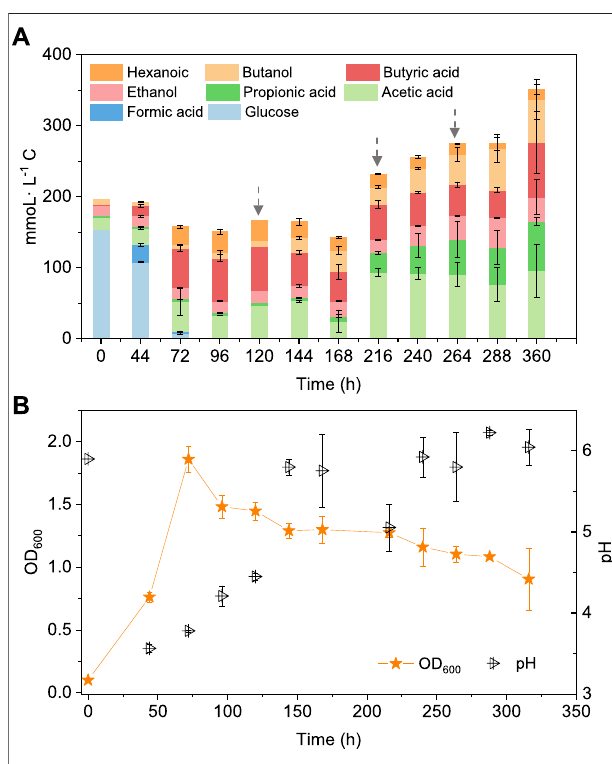
FIGURE 4 | (A) Production of acids and alcohols and (B) cell concentration and pH by enriched sludge using 5 g/L glucose as the